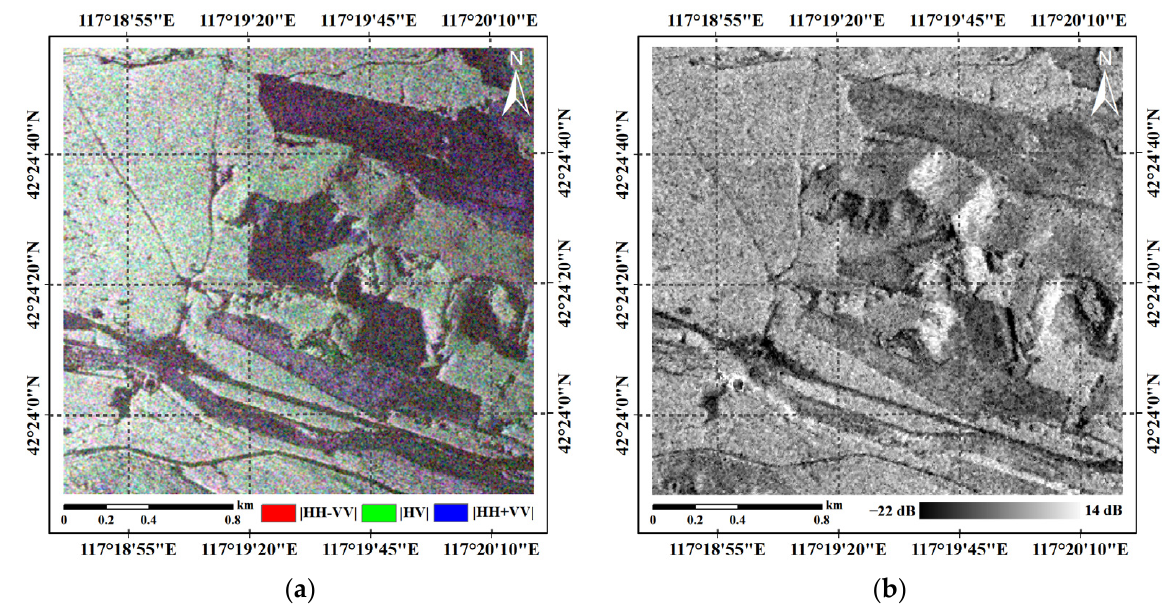
Figure 6. The primary images of P-band and X-band InSAR: ( a ) Pauli RGB display of the P-band primary image; ( b ) Intensity display of X-band primary image.